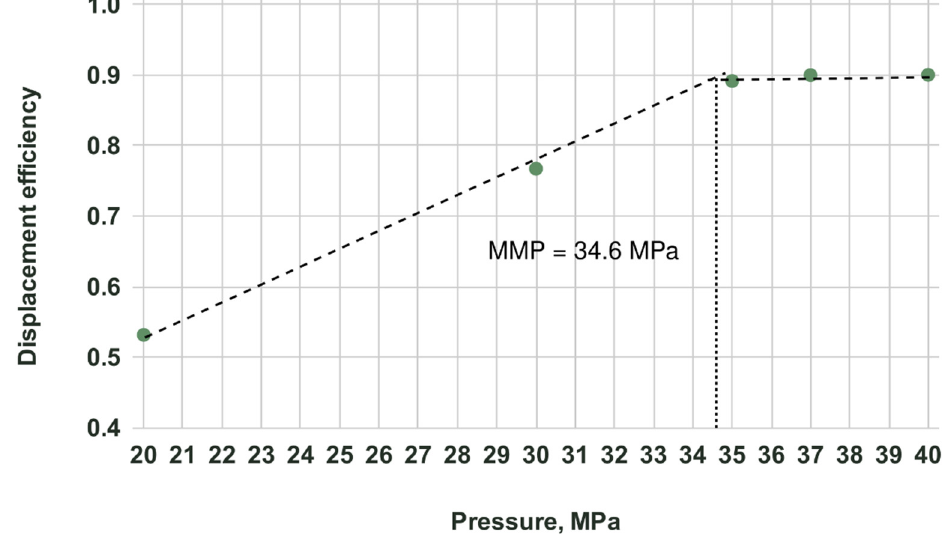
Figure 3. Minimum miscibility pressure for APG displacement.